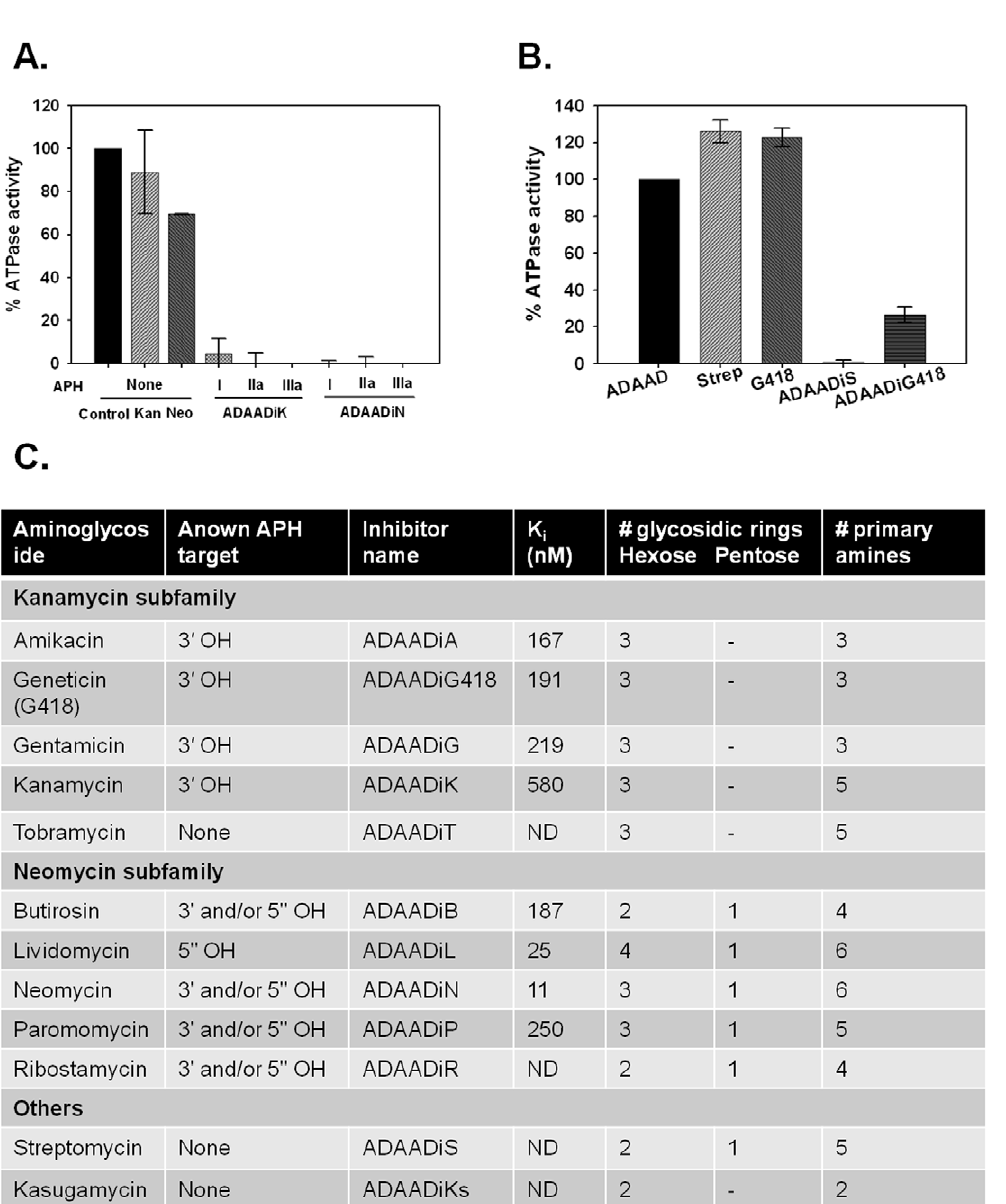
Figure 3. ADAADi formation is catalyzed by different isoforms of APH using different aminoglycoside substrates. (A). APH (3 9 )-I, APH (3 9 )-IIa, and APH (3 9 )-IIIa catalyze ADAADi formation. ADAADi, synthesized by the three isozymes of APH, was purified and ATPase assays with 0.22 m M His-ADAAD and 68 m M kanamycin (Kan), 44 m M neomycin (Neo), 1.6 m M ADAADiK from APH(3 9 )-I (I) and APH(3 9 )-IIa (IIa), 1.2 m M ADAADiK from APH(3 9 )-IIIa (IIIa), 1.6 m M ADAADiN from APH (3 9 )-I (I), 2 m M ADAADiN from APH(3 9 )-IIa (IIa) , and 1.4 m M ADAADiN from APH(3 9 )-IIIa (IIIa) were done as described. (B). ADAADi is produced from G418 as well as streptomycin by APH (3 9 )-IIIa. ATPase assays were done either in the absence or presence of 200 m M streptomycin, 2 m M G418, 4 m M ADAADiS, 4 m M ADAADiG418. (C). ADAADi produced using APH (3 9 )-IIIa from commercially available aminoglycosides.